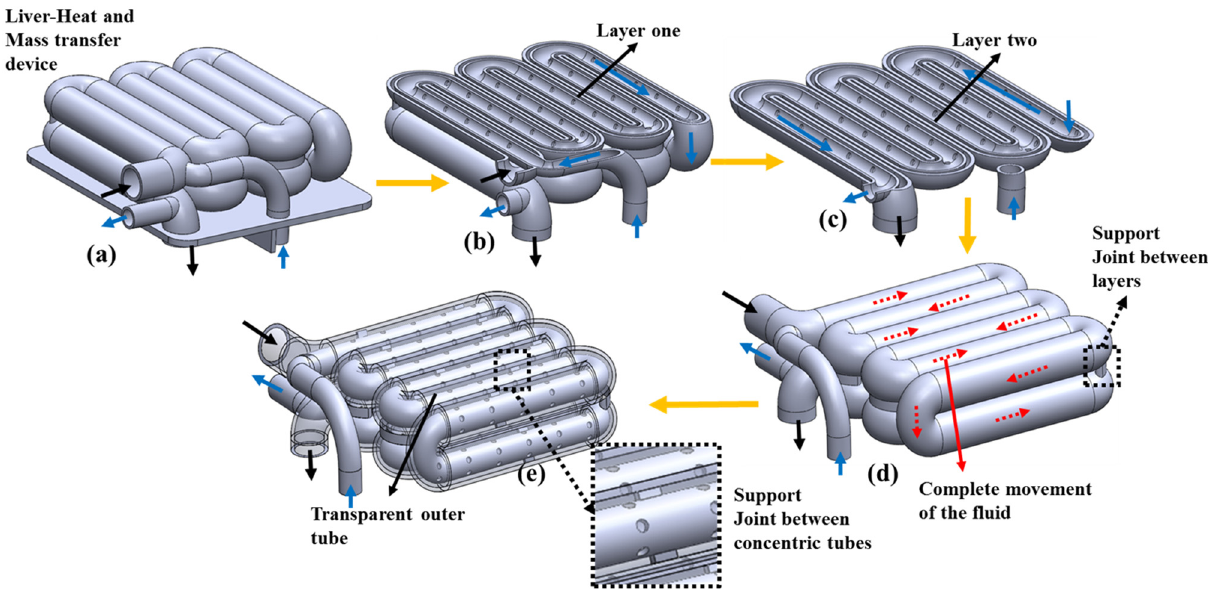
Figure 4. Schematics of the concentric tubes of LHMT device. ( a ) Upper chamber of the concentric tube with a chamber partition wall and with details of the lower chamber’s concentric tube inlet and outlet partition wall. ( b ) Cut section of layer one of the concentric tube, ( c ) cut section of layer two of the concentric tube, ( d ) details of the complete movement of the fluid in the concentric tube, with the highlighted details of the solid support joint between layer one and layer two, and ( e ) transparent view of the outer wall of the concentric tube, showing the inner wall, with the details of the solid support joint between the concentric tubes.